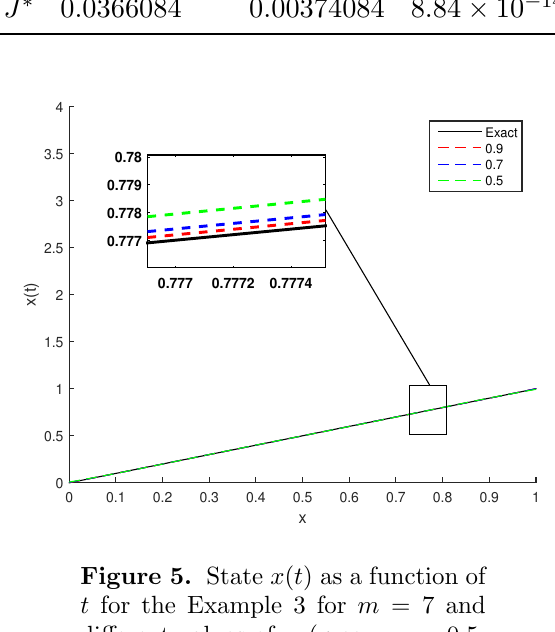
Figure 5. State x ( t ) as a function of t for the Example 3 for m = 7 and different values of α (green: α = 0 . 5, blue: α = 0 . 7, red: α = 0 . 9).